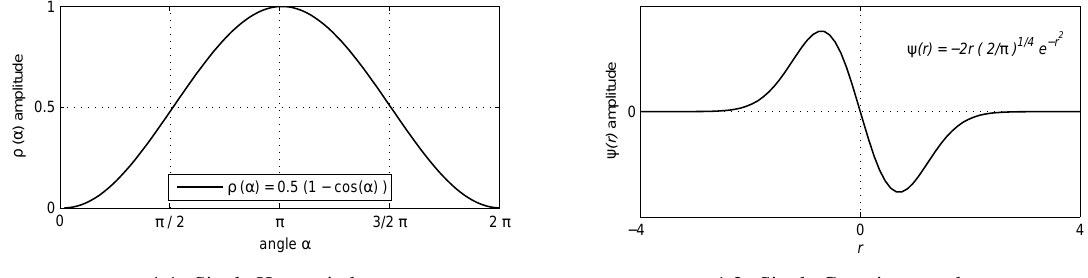
Fig. 1. Hann Window and Gaussian